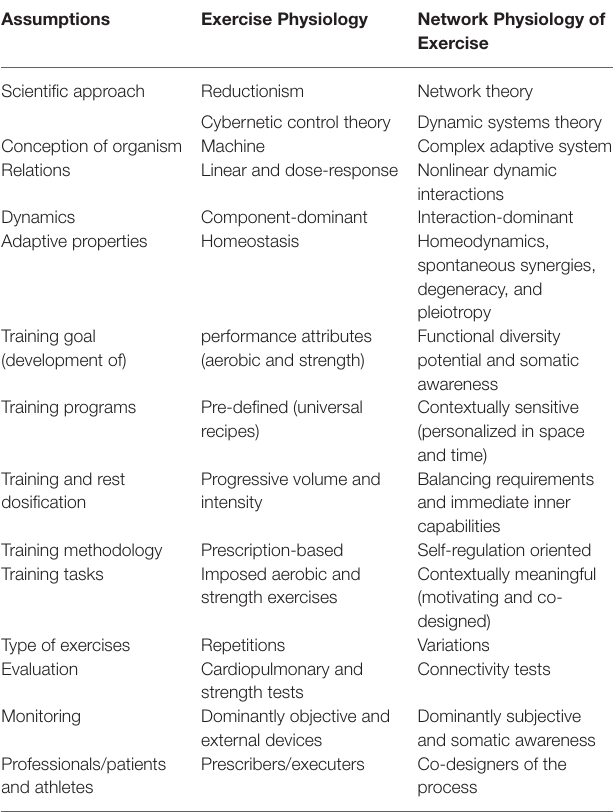
TABLE 1 | Contrast between theoretical and practical assumptions of training under Exercise Physiology and Network Physiology of Exercise (NPE)